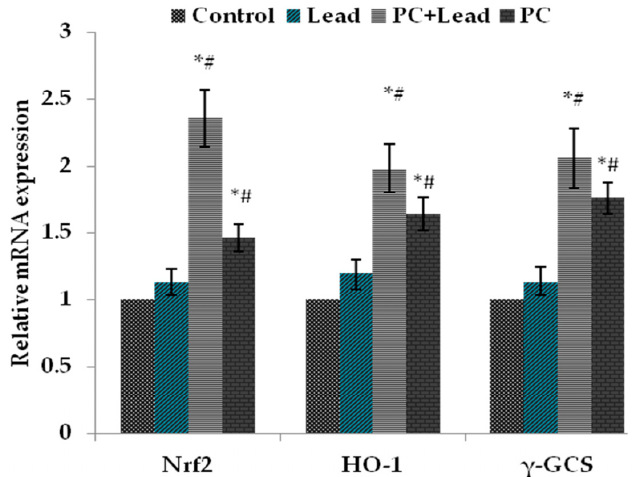
Figure 6. The effect of proanthocyanidins (PCs) on the mRNA expression levels of the nuclear Nrf2 , HO-1 , and γ -GCS in liver tissues of mice exposed to lead. All results are expressed as the mean ± SE ( n = 7). * p < 0.05, significant change with respect to the control; # p < 0.05, significant change with respect to lead-treated mice.